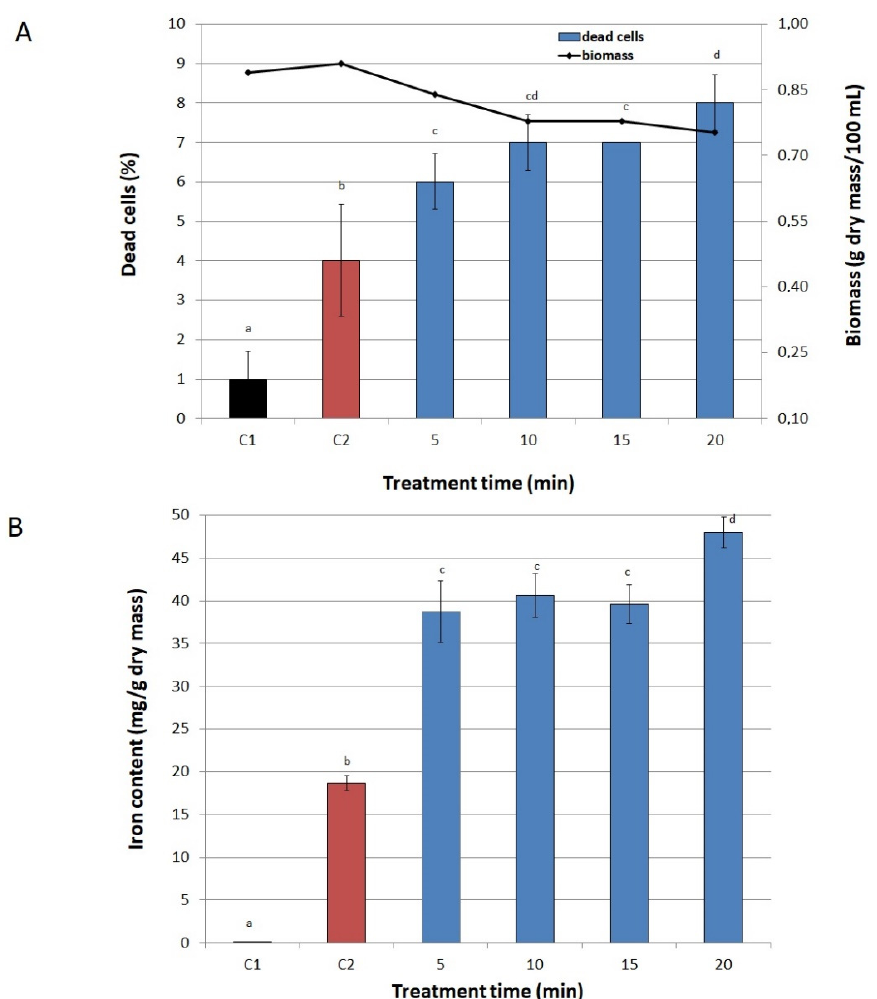
Figure 5. Effect of treatment time on viability of cells and biomass ( A ) and on iron accumulation in yeast cells ( B ). C1—control culture without iron ions added to the medium and PEF treatment, C2—control culture with iron ions added to the medium (200 µ g/mL) and without PEF treatment, blue bars—cultures treated with PEF (ferric nitrate, 200 µ g Fe 3+ /mL, voltage 1500 V, pulse width of 10 μ s, after 20 h of cultivation). Each value is the mean ± standard deviation ( n = 3). Bars with the same letter (a–d) are not significantly different ( p < 0.05).